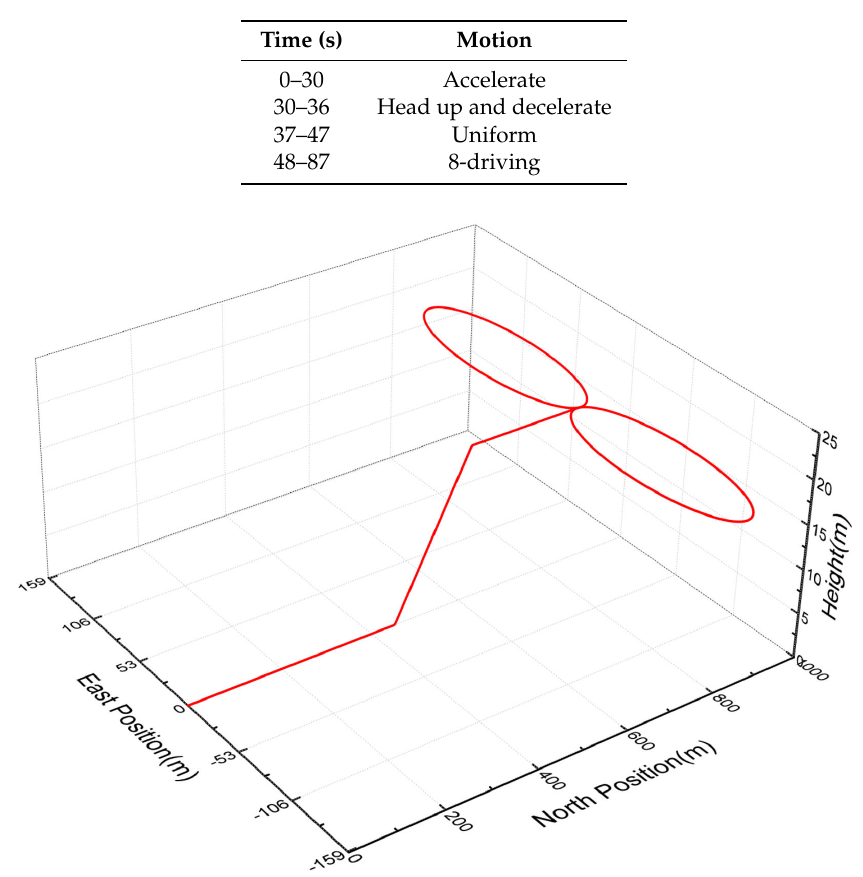
Figure 1. The three dimensional trajectory of the